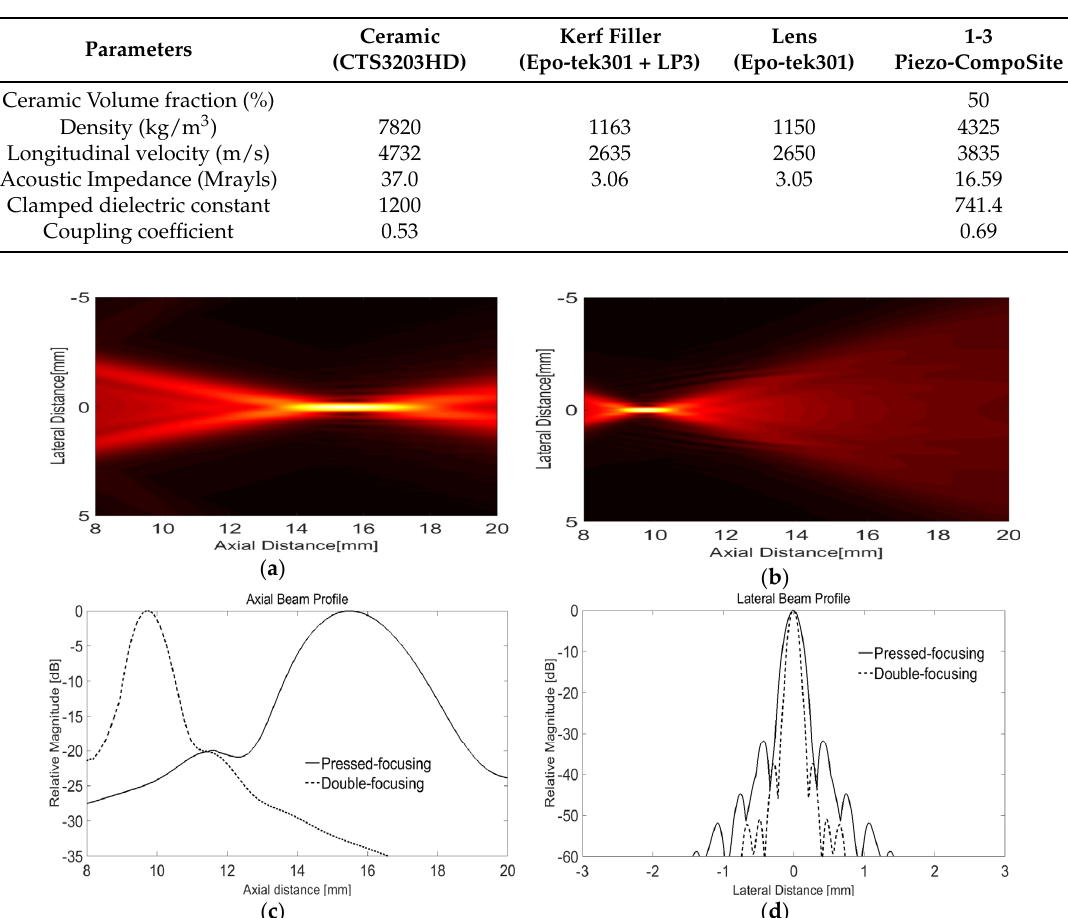
Table 2. Material properties of ceramic, kerf filler, lens, and 1-3 piezo-composite used for the double-focused transducer.